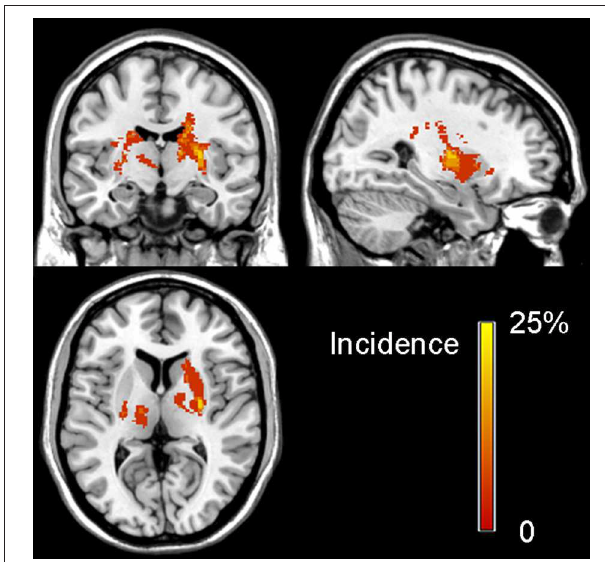
FIGURE 1 | Lesion incidence map of patients with stroke in the chronic stage. The color bar denotes the probability of lesion distribution.